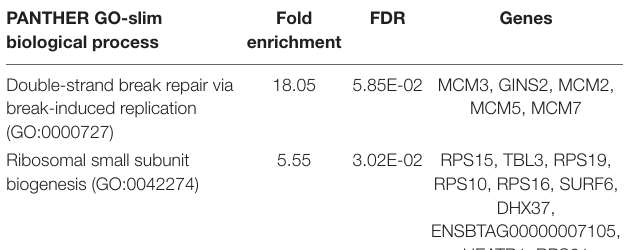
TABLE 4 | Enrichment of genes contributing to the second dimension of between-class PCA (negatively correlated) and associated with ICM from the “SF + PGE2” IVP treatment group.